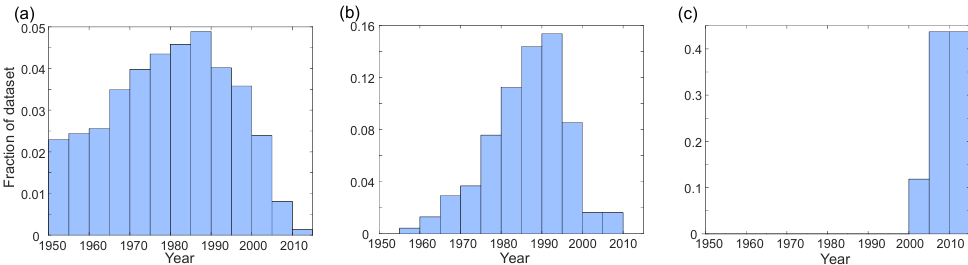
Figure 6. Histograms showing the fraction of accumulation measurements by year for (a) Antarctica, (b) Greenland excluding Summit Station, and (c) Summit Station. Dates are only shown from 1950 forward.